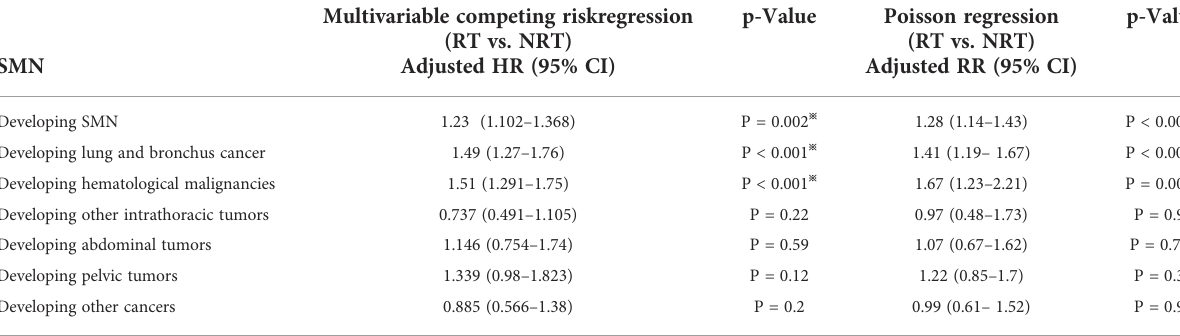
TABLE 2 Risk of developing SMNs in patients with bladder cancer by statistical method. Multivariable competing riskregression p-Value Poisson regression (RT vs. NRT) (RT vs.